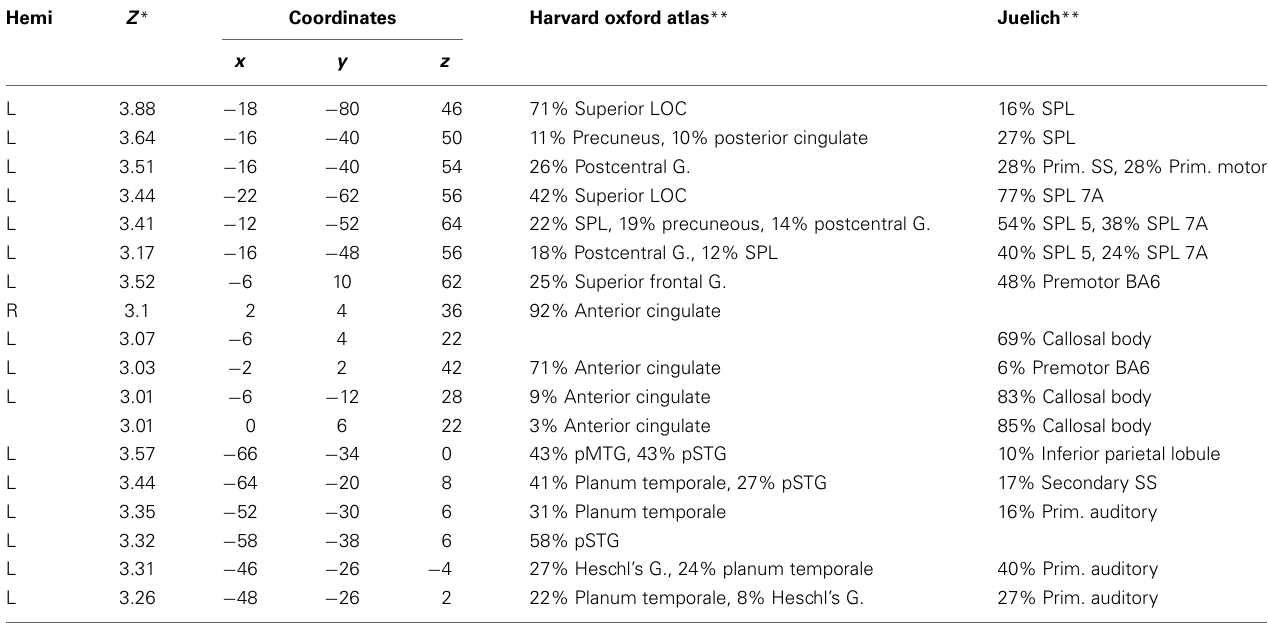
Table 1 | Periphery (11–15) vs. central (2–7): deaf > hearing. Hemi